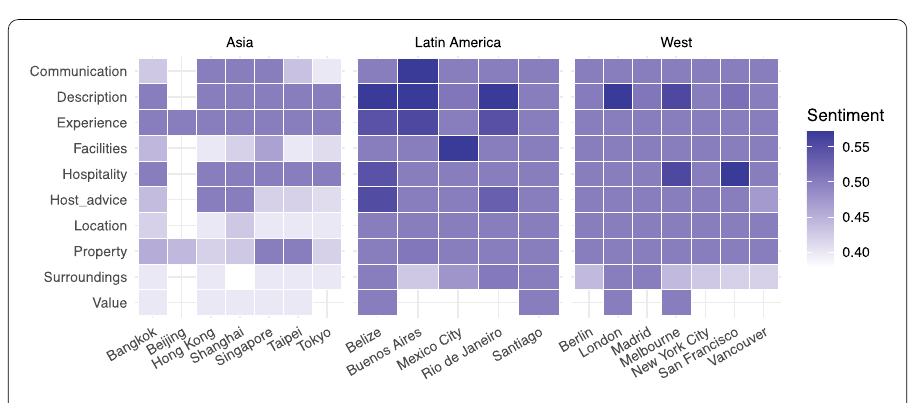
Figure 13 Mean sentiment aggregated by